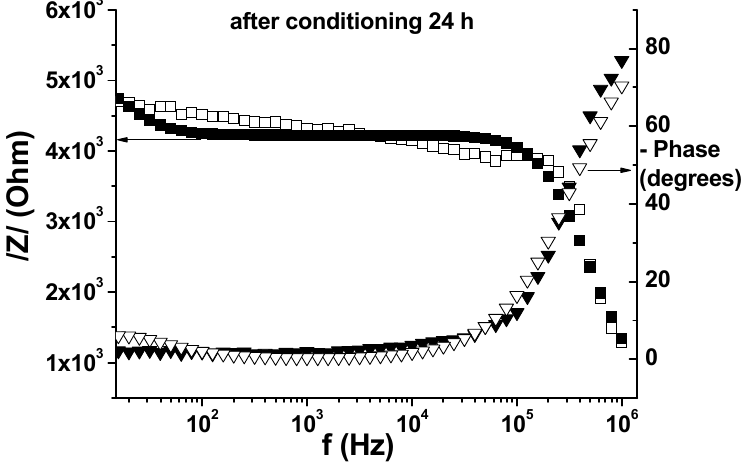
Figure 9. Bode plot for the conditioned membrane; the open symbols represent the fit of the experimental data, based on the electrical circuit presented in Figure